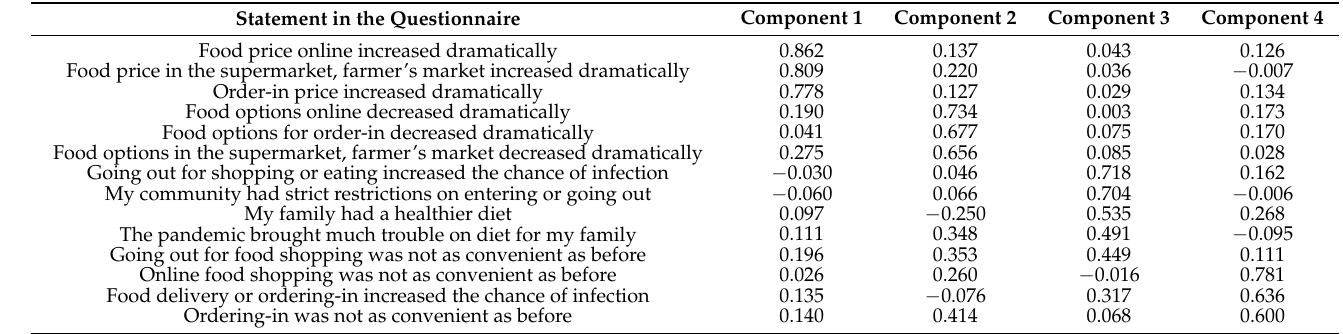
Table 4. Results of principal component analysis regarding perceptions of the CFE during the pandemic.